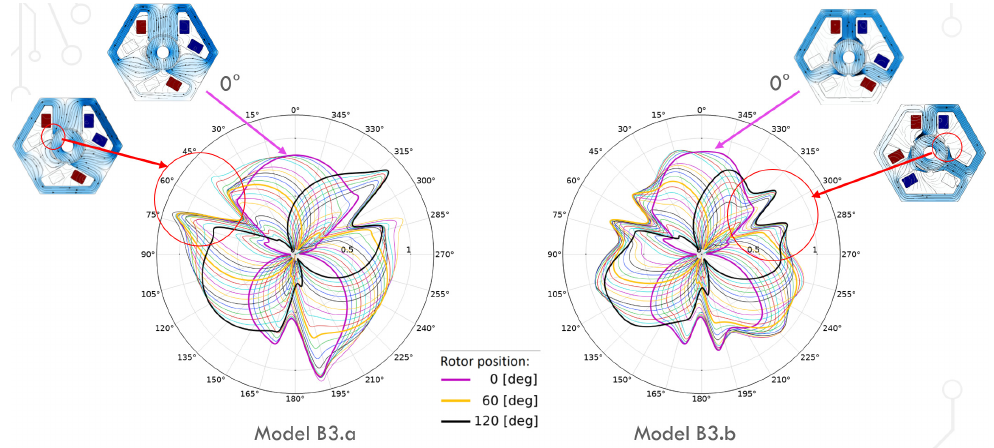
Figure 14. Magnetic flux density in the gap for the rotor position from 0° to 120° (rotated every 6 degrees), model B3.a and model B3.b. The switching of the coil voltage is considered. The radius corresponds to the magnetic flux density value in tesla. The line shapes are very similar in particular pairs of models (_.a and _.b), so only models B3.a and B3.b are presented.